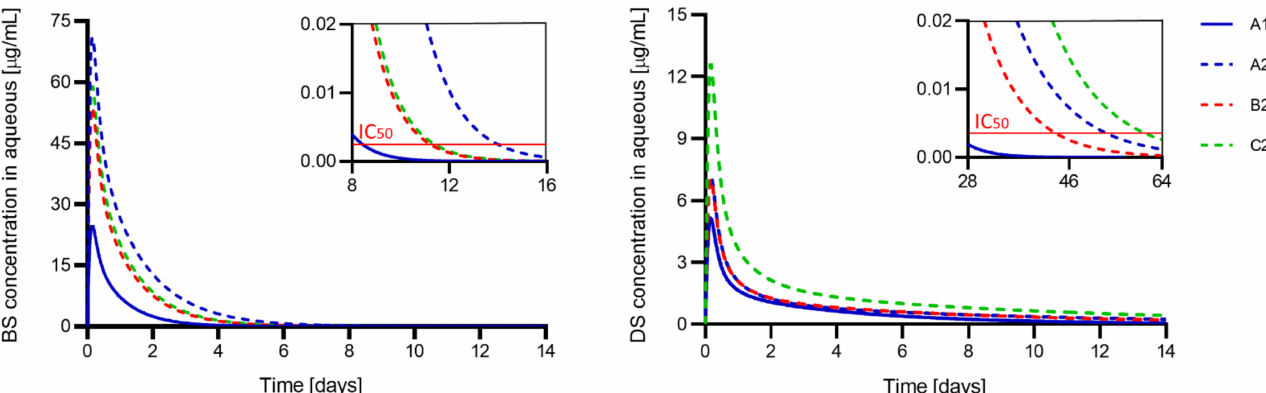
Figure 4. Estimation of the in vivo concentration of bromfenac sodium (BS, left) and dexamethasone sodium (DS, right) in the aqueous humor over time after the implantation of drug-loaded hydrogel discs as IOLs. The horizontal red line in the upper boxes indicates the IC 50 concentration of each drug. Hydrogel codes as in Table 1. Bromfenac sodium is expected to be released by A2 hydrogels for the longest time (14 days) at therapeutic drug concentrations (i.e., above IC 50 = 2.65 ng/mL [57]). The